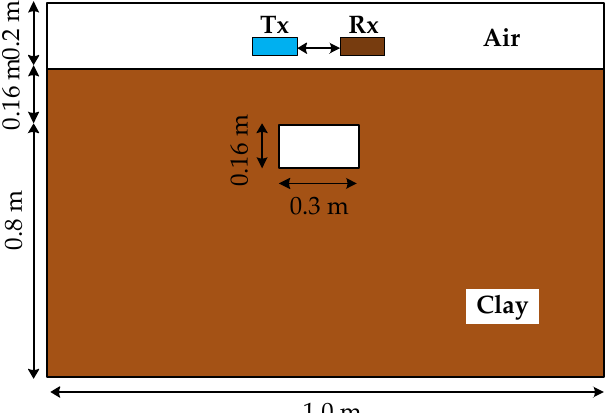
Figure 19. Two-dimensional experimental model.